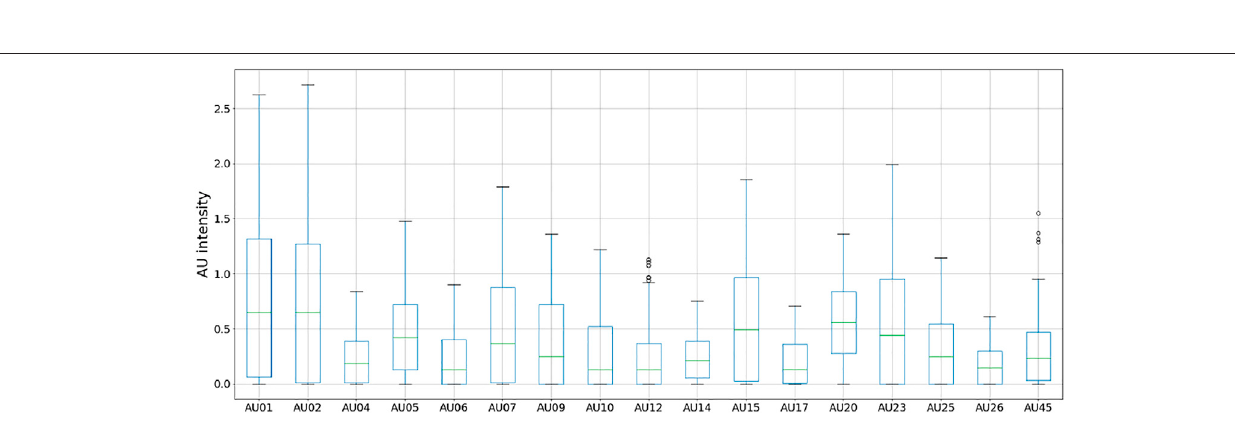
Frontiers in Robotics and AI |